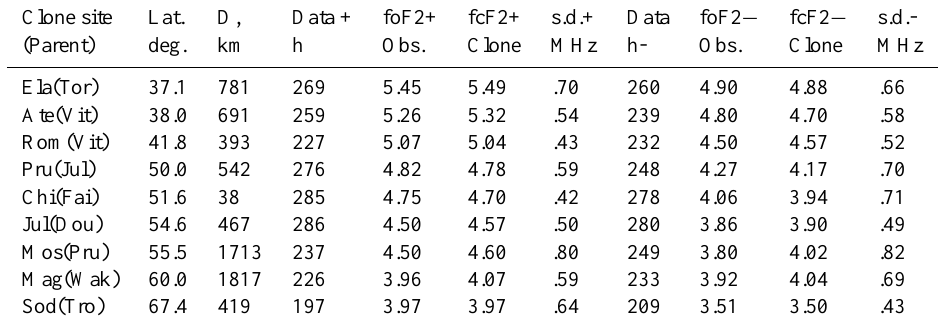
Table 2. Mean value of observed foF2 and cloned fcF2 (MHz) at 9 stations (parent station is indicated) for monthly 1 positive disturbed day (+) and 1 negative disturbed day ( − ) during all the months of 2006. Standard deviation between cloned fcF2 and observed foF2 data, s.d. Distance at altitude of 300km above the ground between the clone site and parent site, D. Number of considered hourly values, h. Clone site